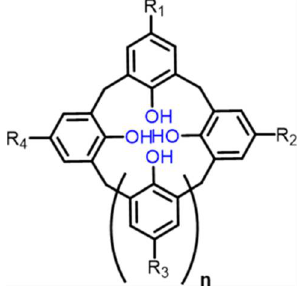
Figure 10. General structure of Calix(n)arenes, where n could be equal or higher than 4. In another work, Temel and coworkers used an R2-bromopropyl functionalized ca- lix[4]arene for sensor development, and determined that this compound was most sensi- tive to toluene vapors in aqueous media [129]. On the other hand, modification of this same position with a triazine structure was reported by Halay and coworkers in 2019. This modification provided the greatest sensitivities to chlorinated hydrocarbons dichloro- methane > chloroform > carbon tetrachloride [131]. Finally, an amino morpholine modi- fied calix[4]arene was also investigated for multiple VOC sensing, and was determined to have a high response to formaldehyde vapor. The sensitivity of this system was deter- mined to be 0.67 ppm. Selectivity of this sensor for 1.85 ppm formaldehyde was estab- lished under relative humidities ranging from 33% to 97%, as well as in the presence of other potentially interfering VOCs that were maintained at 30 ppm with 97% relative hu- midity. While all sensors in these investigations were developed and obtained specific analyte responses, sensor arrays to discriminate between gases were not established in these studies, which could be attributed to low intermolecular forces and low sensitivity as a result of relatively small inner cavities. In this respect, Acikbas and coworkers investigated the use of pillar[5]arenes (P5-P4) for chlorohydrocarbons VOC detection and discrimination [133]. By incorporating a larger central cavity along with strategic functionalization, these authors hypothesized that monolayers of this sensing material would provide more substantial host–guest in- teractions. In this work, P5-P4s were similar to the general calix[n]arene structure depicted in Figure 9, where n equals 2. These investigators functionalized central hydroxyl groups,